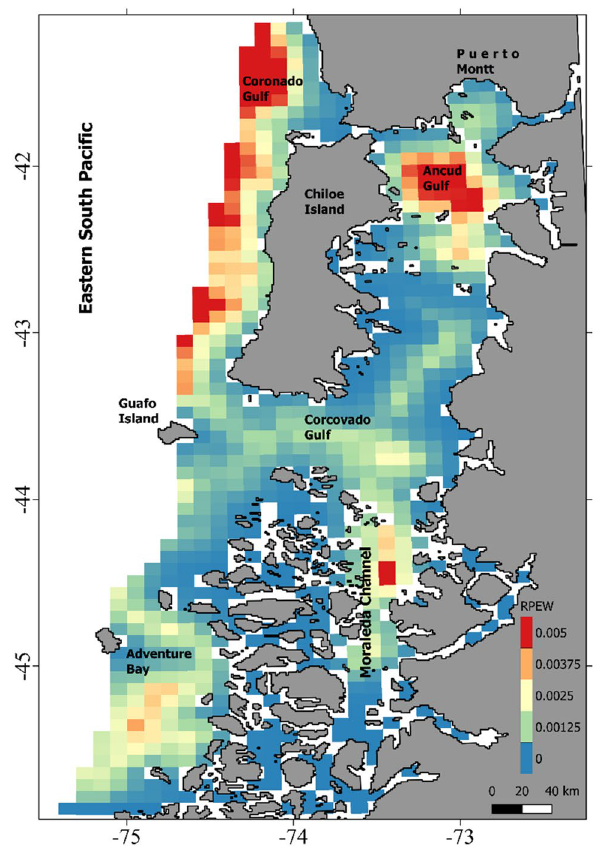
Figure 5. Relative probability of encountering a blue whale (RPEW). This integrates the output of the movements and species distribution models for areas within 25 km from shore. Data layers (including the map) were created in R ver. 4.0.2 (www.r-proje ct.org) and ensembled in QGIS ver. 3.8.0 (www.qgis.org) for final rendering. Map was created using data on bedrock topography from the National Centers for